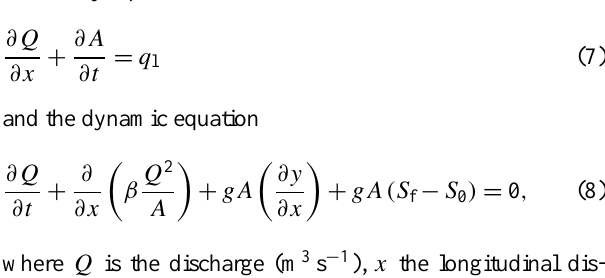
steady and unsteady flows in fluvial and transcritical